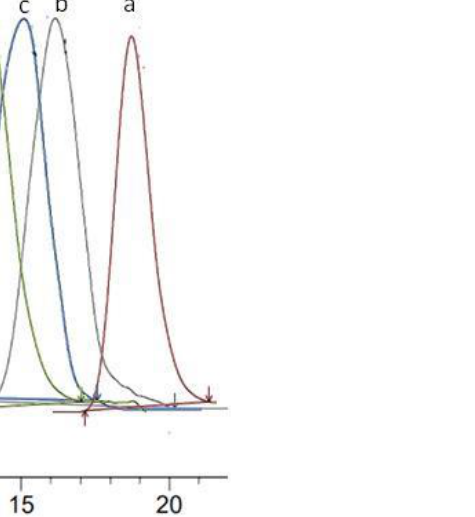
Figure 7. Superposition of SEC chromatograms of PEA-2 (a), PCL 2000 -PEA 2500 -PCL 2000 (b), PCL 5000 - PEA 2500 -PCL 5000 (c) and PCL 7000 -PEA 2500 -PCL 7000 (d).